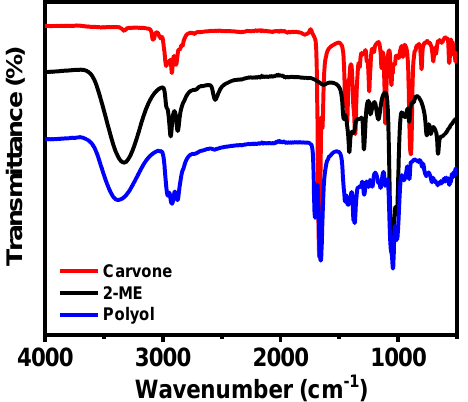
Figure 4. Fourier Transformed Infrared spectra for carvone, 2-mercaptoethanol, and carvone-based polyol.